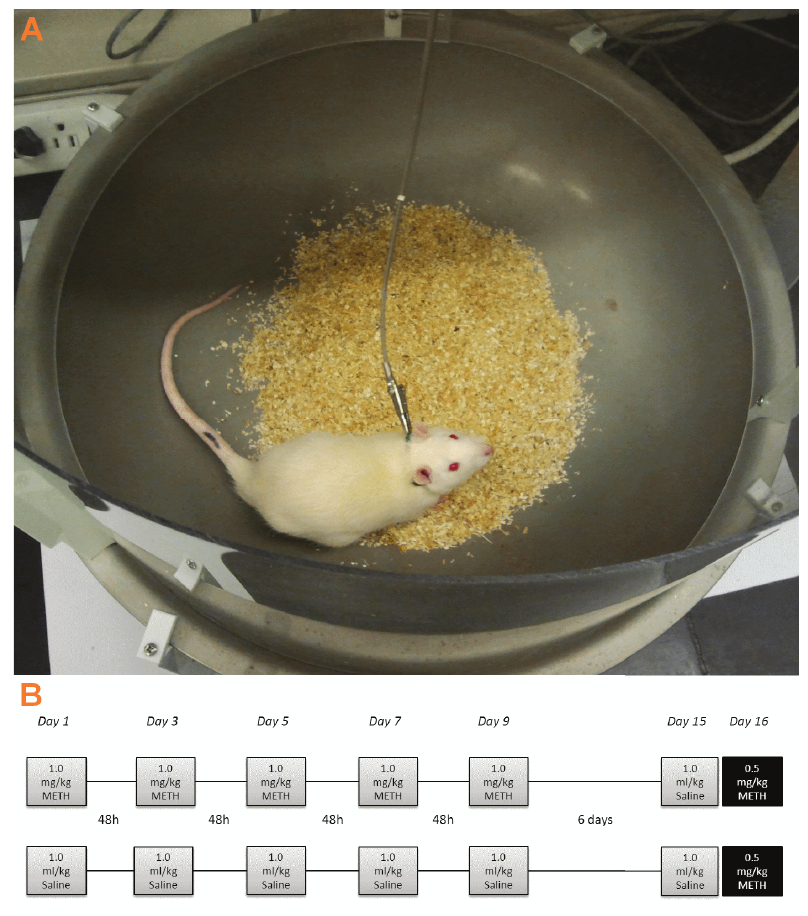
Figure 1. Apparatus and experimental protocol. The locomotor apparatus ( A ) consists of a rotating actuator anchored to a U-shaped bracket over a steel bowl-shaped arena (Med Associates; 18 in top diameter, 6 in bottom diameter, 6 in depth) containing a layer of Sani-chip bedding. The rat is attached to the actuator via 45 cm spring leash terminated with an alligator clip, which is hooked onto a cable tie around the neck for the duration of the test session. The apparatus registers rotational movements as the rat causes the actuator to pivot, accumulated by computer as quarter turns. The experimental procedure ( B ) consisted of three days of acclimation sessions in the locomotor arenas, followed by five injections of METH (1.0 mg/kg, i.p.) or saline separated by 48 hr (Days 1, 3, 5, 7 and 9). After each injection, rats were placed into the locomotor arenas for 90 min and their rotational data were recorded as quarter turns. Rats underwent locomotor testing following a saline injection on Day 15, and these data were balanced between groups assigned to mGluR5 treatment or vehicle treatment. On Day 16, the rats were given an injection of the mGluR5 ligand (CDPPB or fenobam) or vehicle, and tested 30 min later following a probe injection of METH (0.5 mg/kg, i.p.). Table S1–Table S2). Similarly, in the fenobam experiment, repeated injections of METH but not saline resulted in elevated quarter